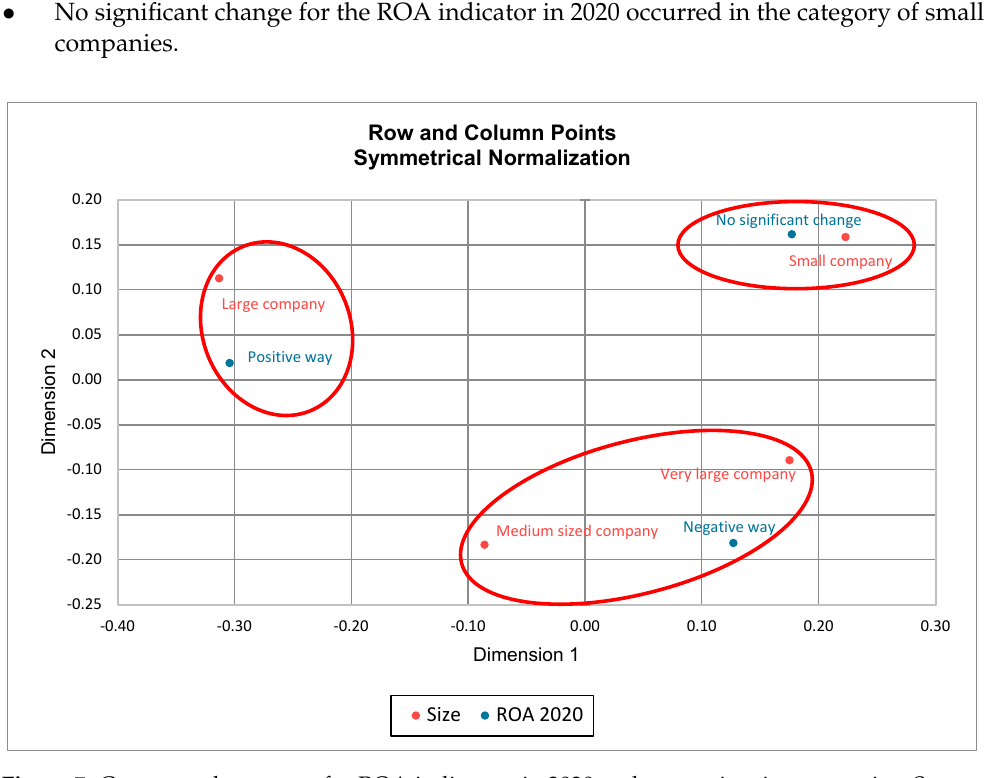
Figure 7. Correspondence map for ROA indicators in 2020 and enterprise size categories. Source: own research .